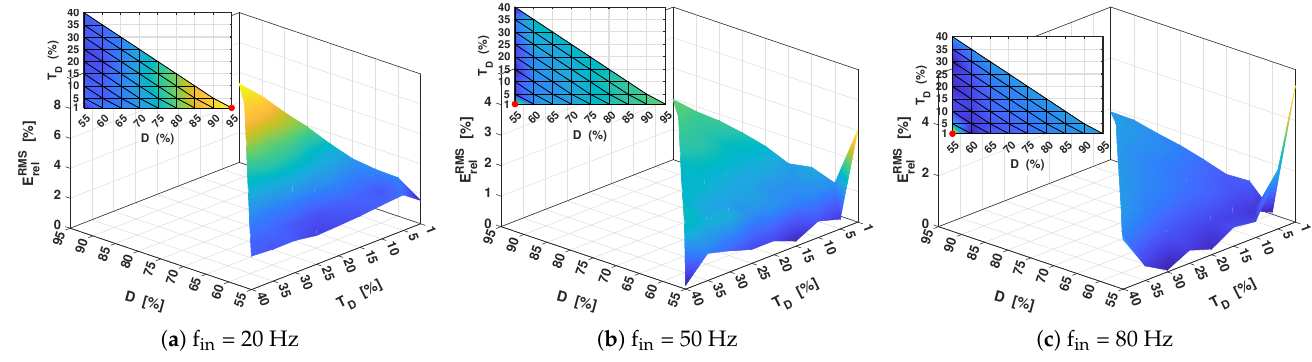
Figure 10. Mapping of the relative errors between measured RMS output voltages and simulated data with respect to Duty Cycle (D) and Time Delay (T D ) at different frequencies (f in ) of the input voltage. The insets show the top view of each surface, while the red dots point out the maximums.